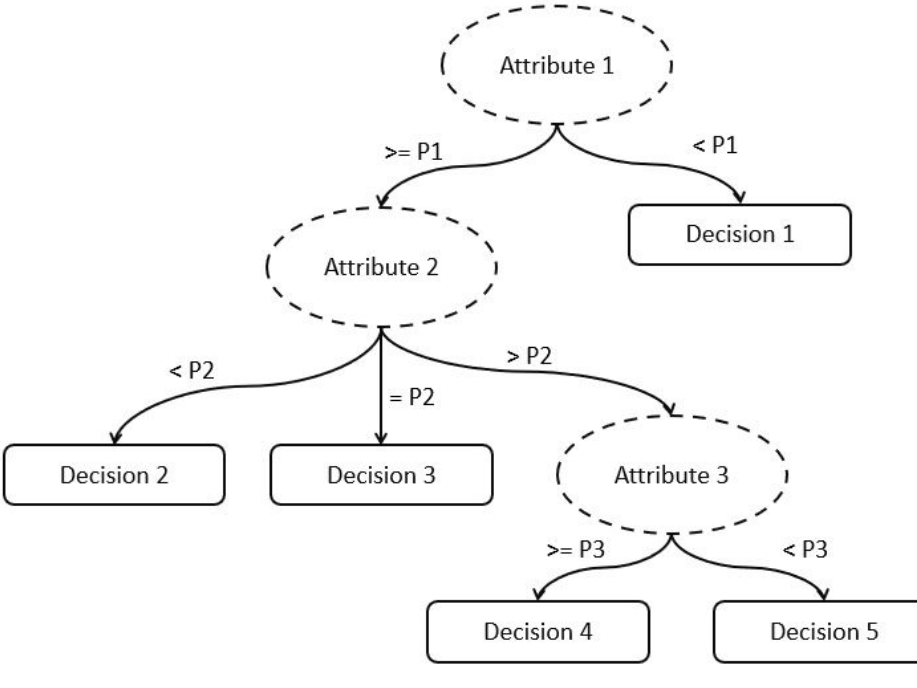
Figure 1. Parameterized decision tree